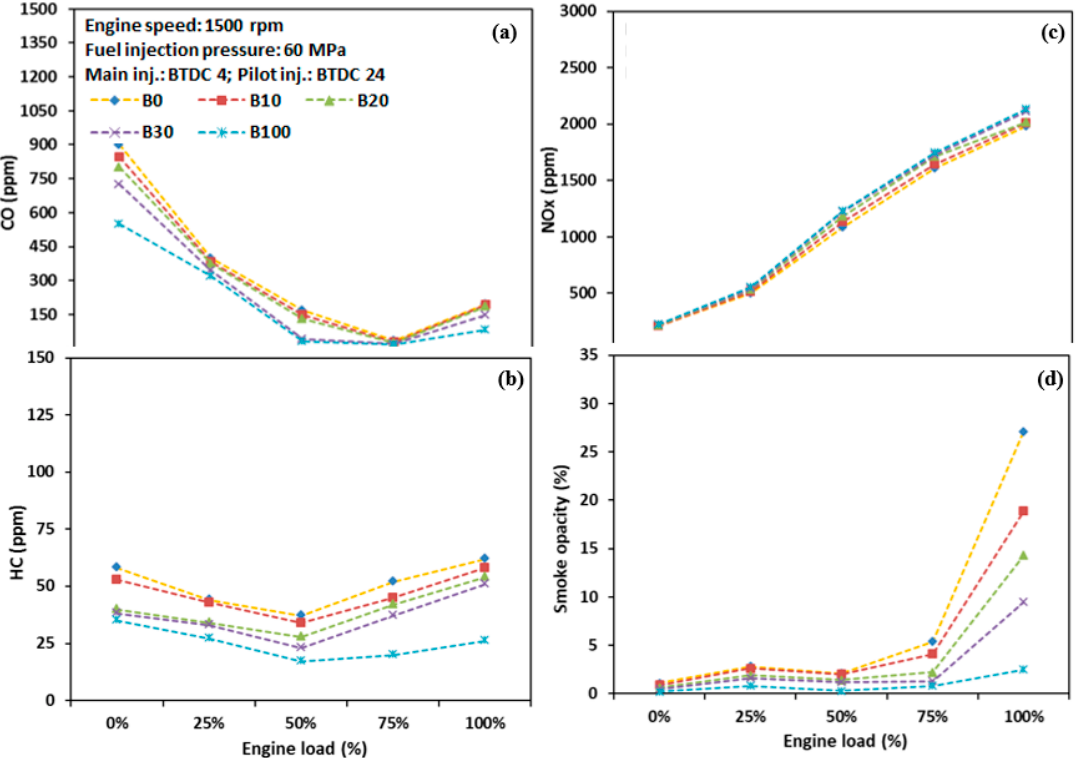
Figure 6. Effect of engine loads on ( a ) CO, ( b ) hydrocarbon (HC), and ( c ) nitrogen oxide (NOx) emissions and ( d ) smoke opacity.